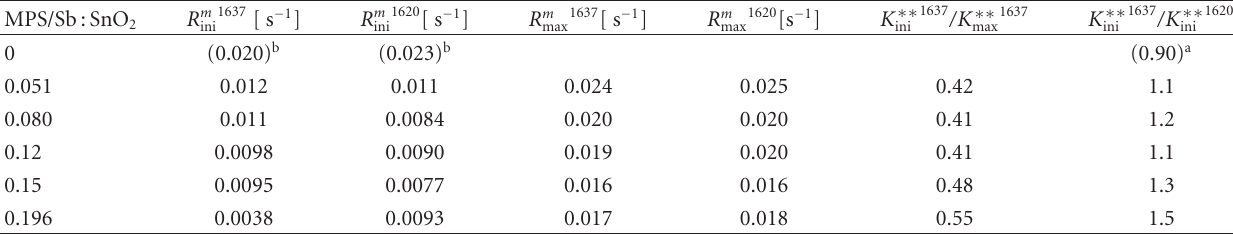
/K ∗∗ /K ∗∗ , K ∗∗ , and K ∗∗ for Sb:SnO 2 /PEGDA 575 formulations. a ini ini ini ini ini